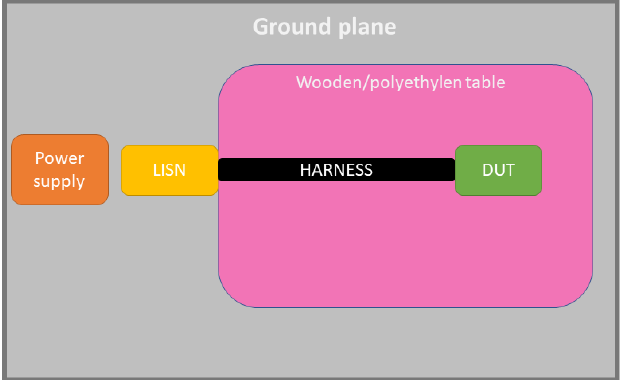
Figure 2. The complete test setup for SMPS module per CISPR 16-2-1.